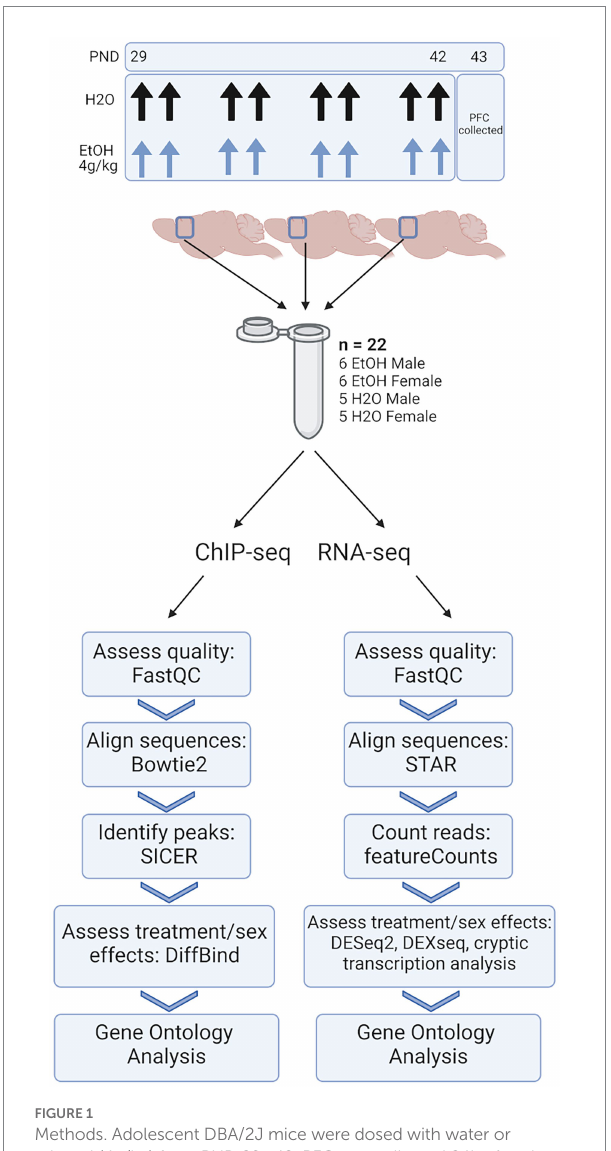
FIGURE 1 Methods. Adolescent DBA/2J mice were dosed with water or ethanol (4 g/kg) from PND 29–42. PFC was collected 24 h after the last dose of ethanol. Three PFCs from each treatment group were homogenized together, divided, and subjected to ChIP-seq and RNA-seq